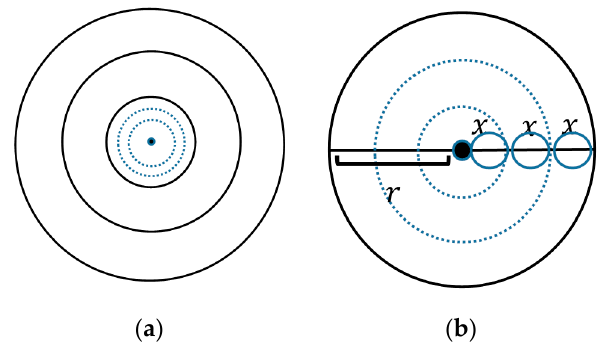
Figure 2. ( a ) Dividing the innermost corona into sub-coronas; ( b ) enlarged view of the innermost corona . innermost